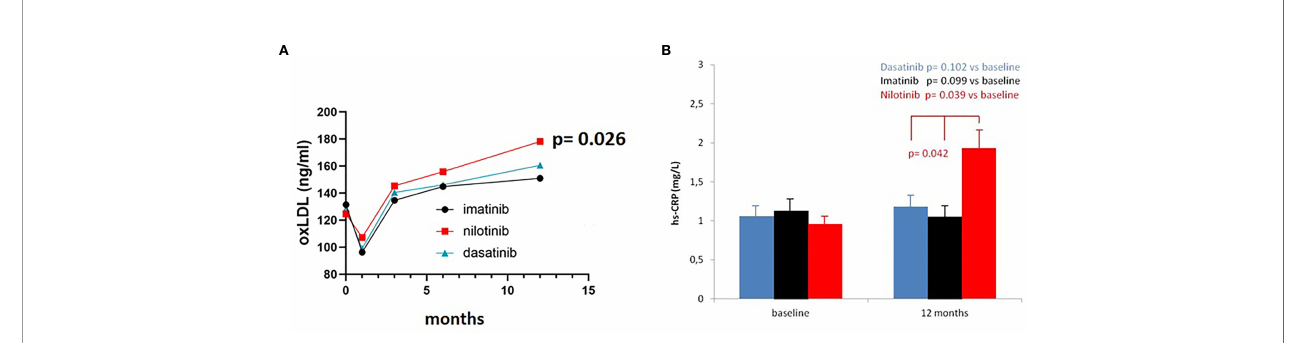
FIGURE 4 | OxLDL and Hs-CRP levels in the three cohorts. (A) Three-way ANOVA. OxLDL levels were comparable between the three treatment arms for the fi rst 6 months. At 12 months oxLDL levels increased in the nilotinib cohort (F= 4.030, p=0.026), compared to imatinib and dasatinib subgroups. (B) Three-way ANOVA. Hs-CRP levels were comparable between the three treatment arms at baseline. At 12 months hs-CRP levels increased in the nilotinib cohort (F= 3.590, p=0.042), compared to imatinib and dasatinib subgroups.